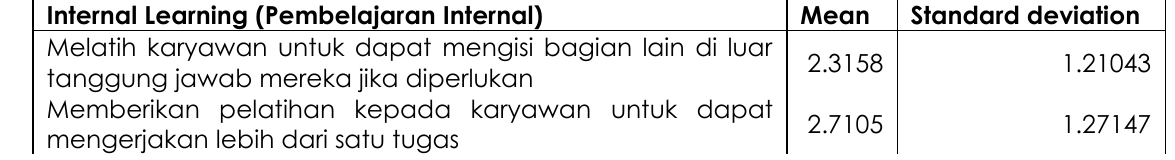
Table 4: Tingkat Pembelajaran